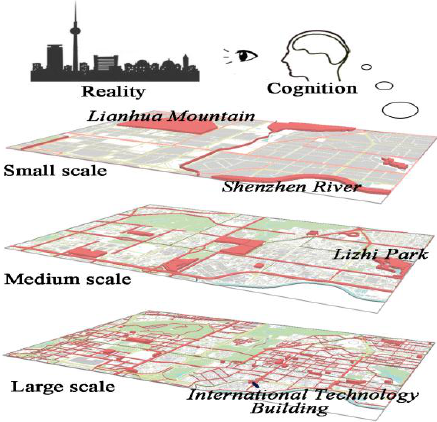
Figure 1. Cognition Schematic Diagram of Urban Landmarks at Multiple Scales.